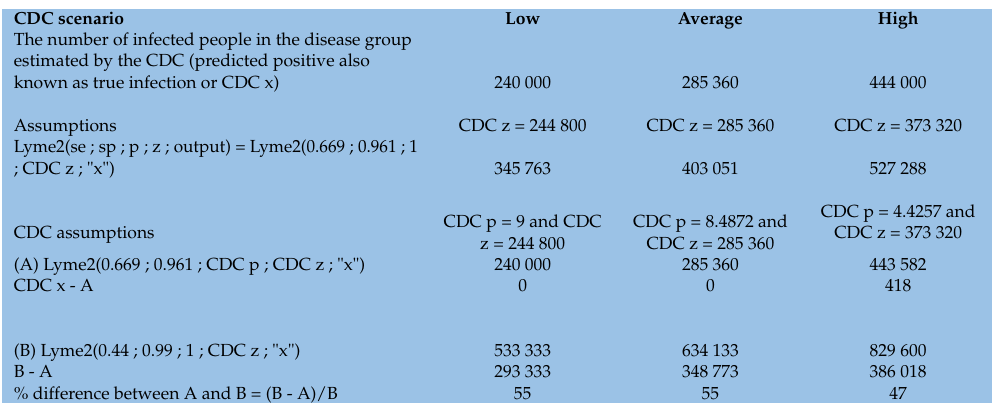
Table 7. Comparison 2 of the CDC model and my Lyme disease